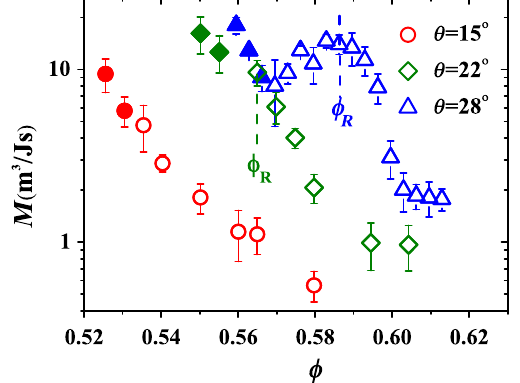
FIG. 4. Mobility M of three grain boundaries with θ ¼ 28 °, 22°, and 15°. Solid symbols represent solid-liquid interfaces after melting. Here, ϕ is marked by vertical dashed lines. R